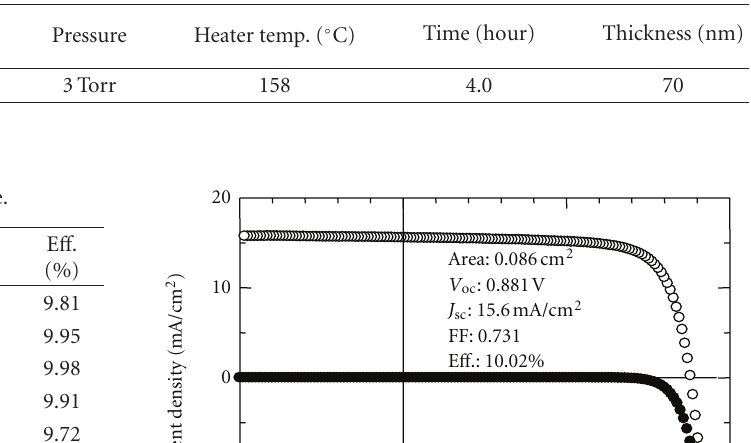
Table 4: ZnO films deposition parameters.